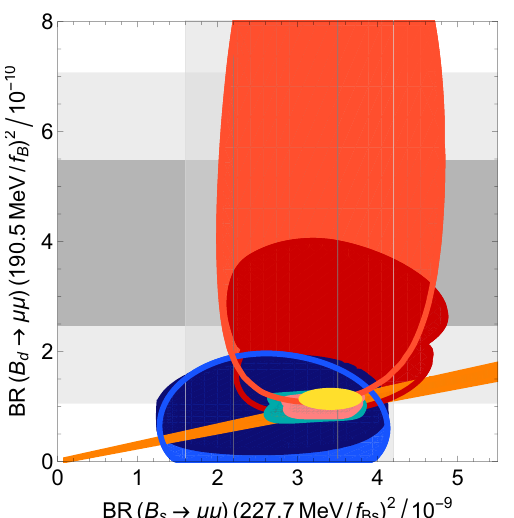
Figure 11. Br ( B d (cid:22) (cid:22) (cid:22) ) vs. Br ( B s (cid:22) (cid:22) (cid:22) ) in G SM at 10 TeV [darker colours] and 1 TeV ! ! (lighter colours), as well as G 0 ((cid:8)) models at 10 TeV. The colours correspond to the representations SM Q V = Q d [red and pink for G SM and G 0 ((cid:8))] and D [similar to T u;d , blue and cyan]. The orange SM band corresponds to a scenario of constrained minimal (cid:13)avour violation (CMFV) [92].